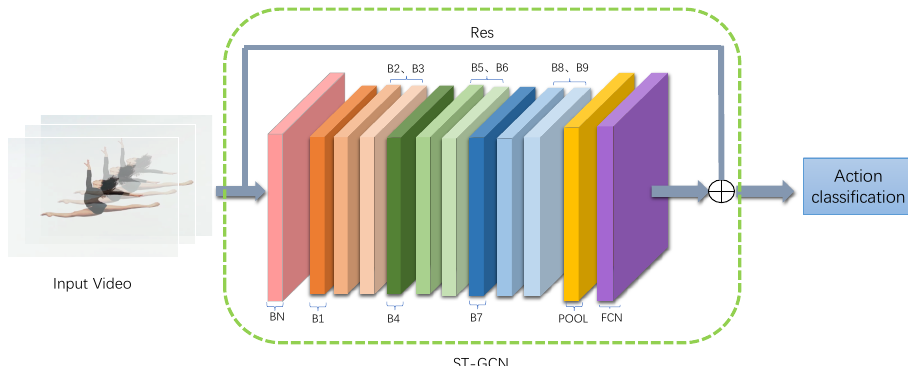
Figure 1. The human action recognition process of ST-GCN.